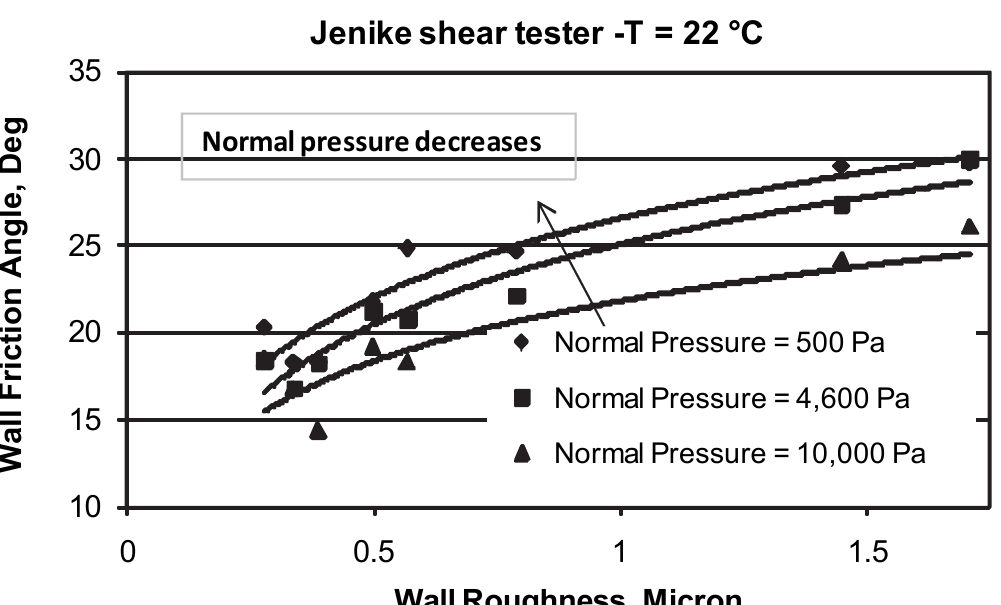
Fig. 6 Wall Friction Angle vs. Wall Roughness (Jenike Shear Tester at 22 ℃